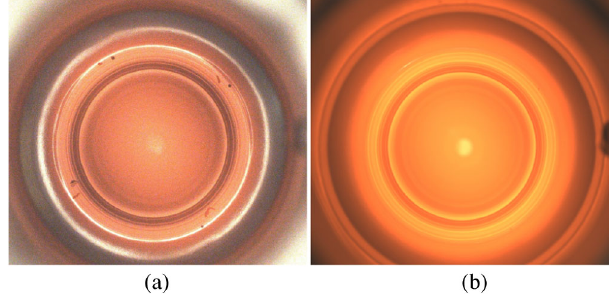
FIG. 3. Glow discharge ignited in the end cell contaminated with permanent marker dots: (a) initial state, (b) final state after 19 hours of plasma